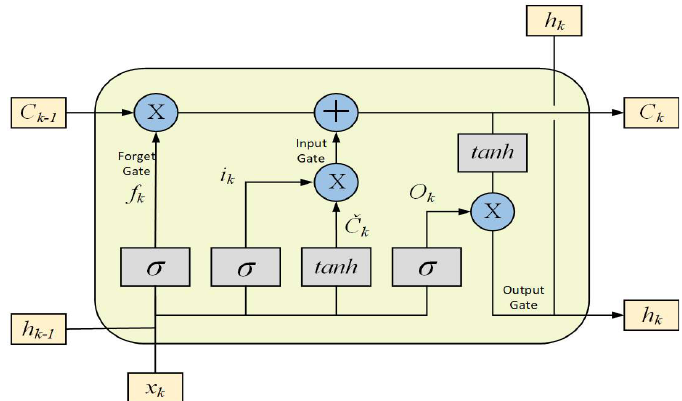
Figure 3. The internal architecture of a LSTM unit containing all of the parameters and gates.